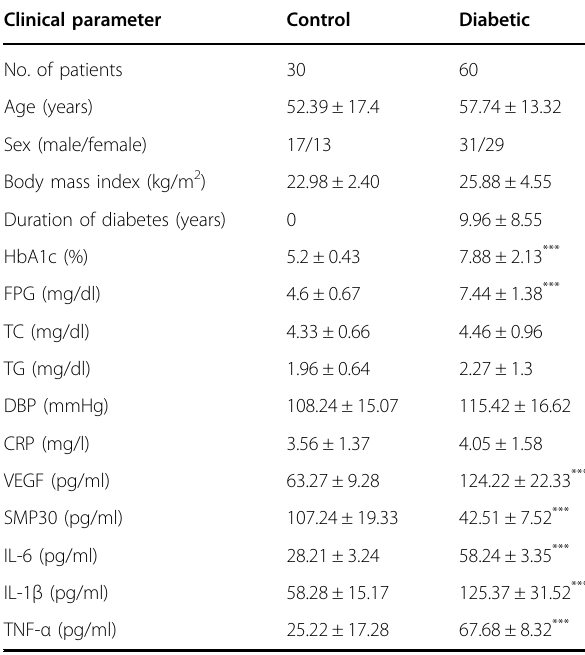
Table 1 Comparison between demographic and laboratory characteristics of diabetic patients and controls Clinical parameter Control